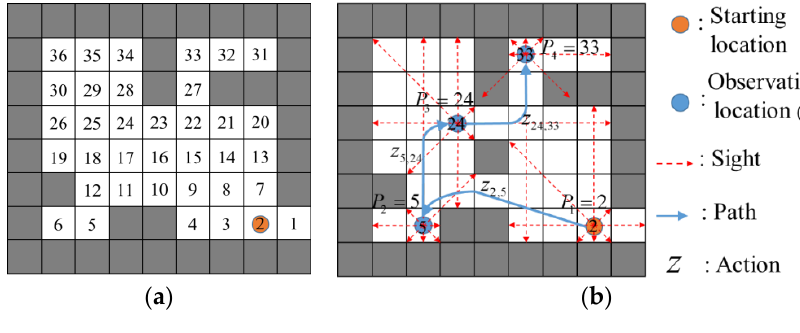
Figure 2. ( a ) Test map; ( b ) optimal path P (2 → 5 → 24 →